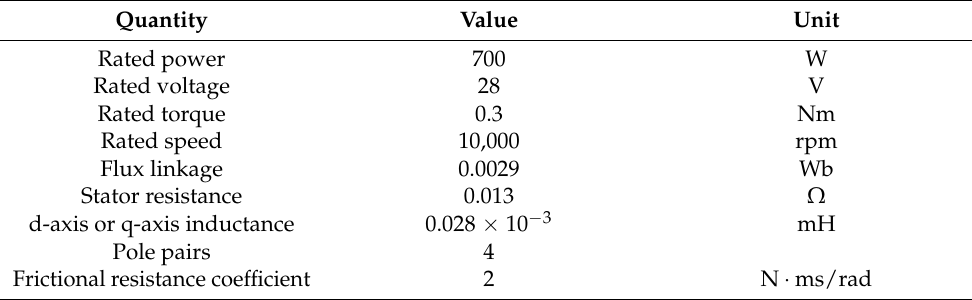
Figure 7. Diagram of the simulation model implemented in Simulink. Table 1. Simulation